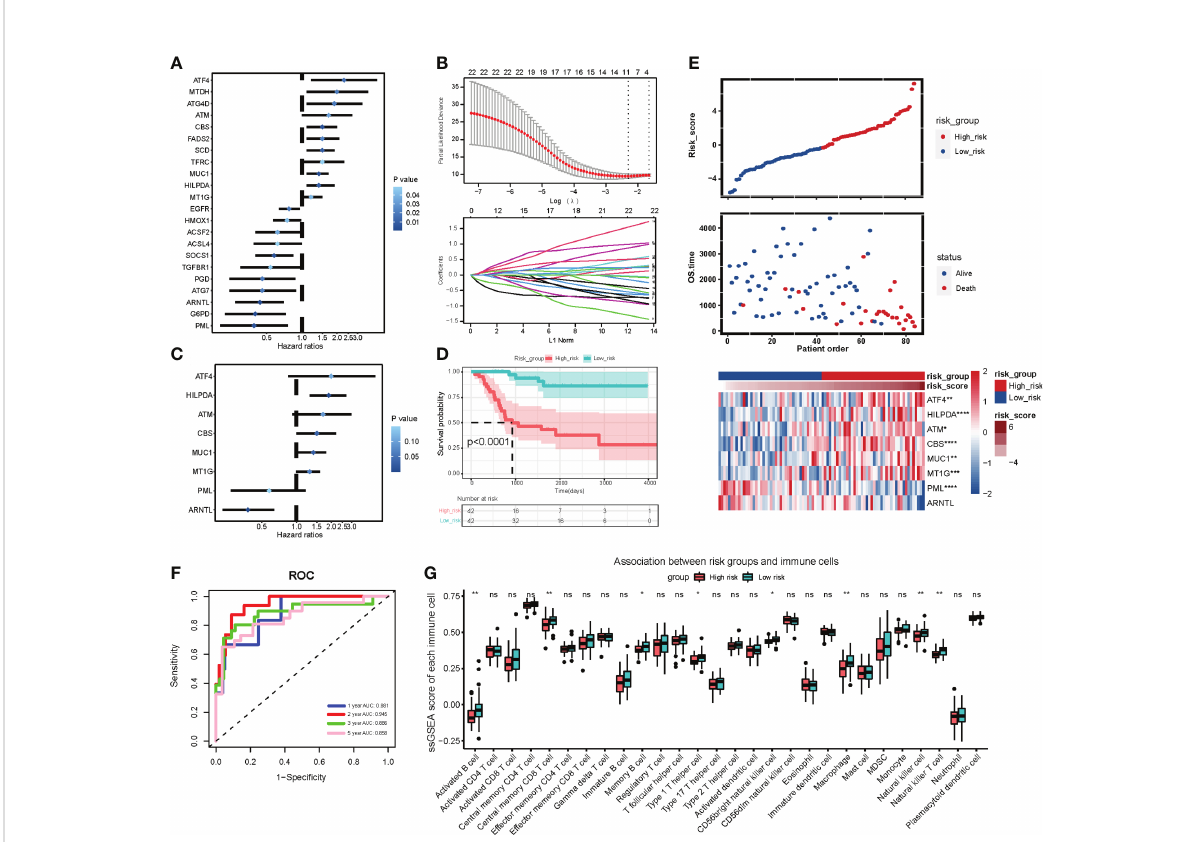
FIGURE 3 Construction and analysis of prognostic signature based on ferroptosis gene expression in TARGET OS cohort. (A) Forest plot of 22 independent prognostic genes identi fi ed by univariate Cox regression analysis ( P < 0.05). Blue represents statistical signi fi cance. The deeper the blue, the greater the signi fi cance. (B) LASSO algorithm con fi rming minimum lambda value. (C) Forest plot of 8 regulators in optimal prognostic model selected by stepwise multivariate Cox regression analysis. (D) Kaplan-Meier analysis exhibiting the overall survival of OS patients in high-risk group and low-risk group graded by the optimal prognostic model. Red represents high risk group and blue represents low risk group. (E) Distribution plots of risk scores and heatmap of signature genes expression in TARGET OS patients. (F) Time dependent receiver operating characteristic (ROC) curve of the ferroptosis signature model in predicting prognosis of OS patients. (G) Box plot of ssGSEA analysis revealing 28 immune cells expression in two risk subgroups. Kruskal test * P < 0.05; ** P < 0.01; *** P < 0.001; **** P < 0.0001; ns, no signi fi